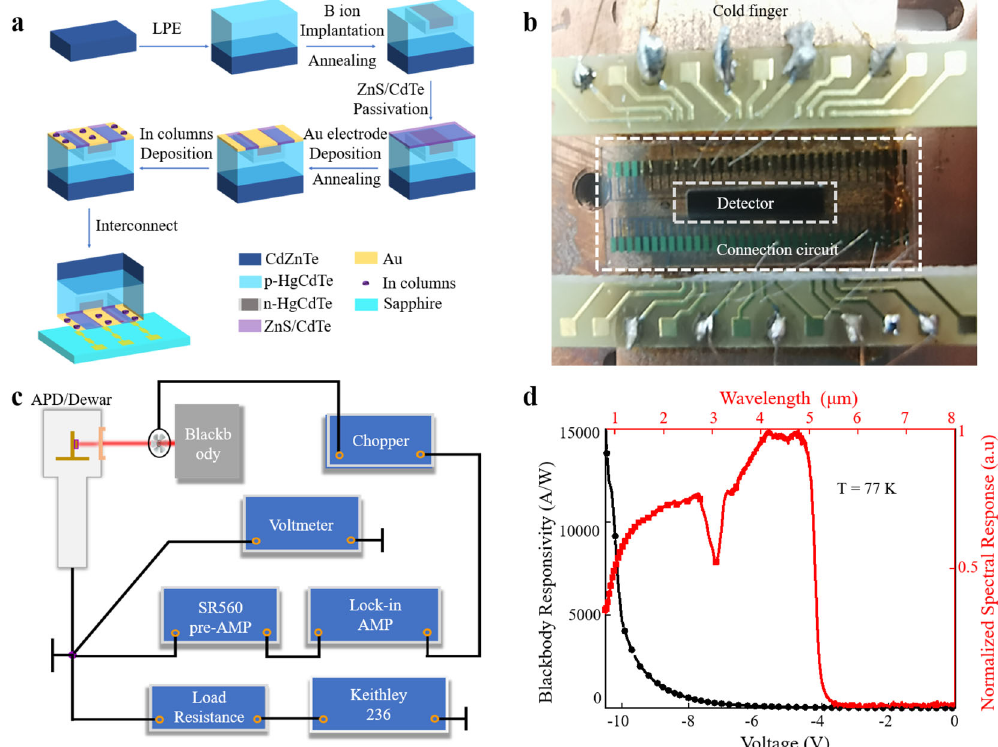
Fig. 4 Fabrication details and the measurement setup. a Flow chart of the fabrication process. b Optical microscope image of the fabricated HgCdTe APD before measurement. c The measurement setup for blackbody responsivity characterization. d Measured blackbody responsivity at different reverse bias voltages and the normalized spectral response of our device at 77